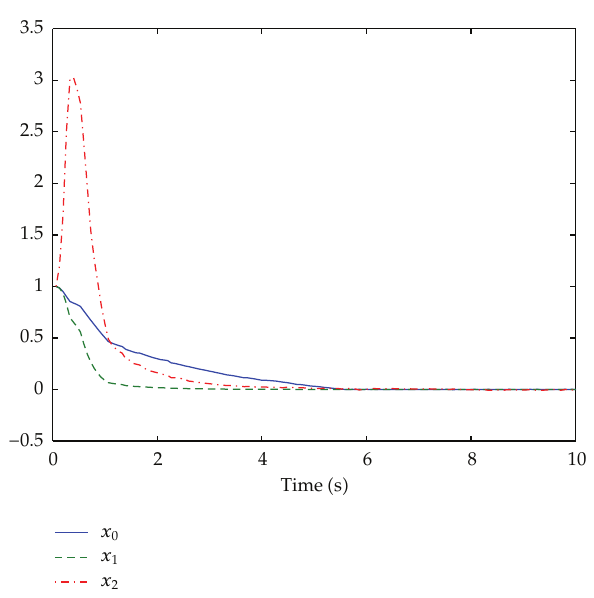
Figure 1: Time history of system